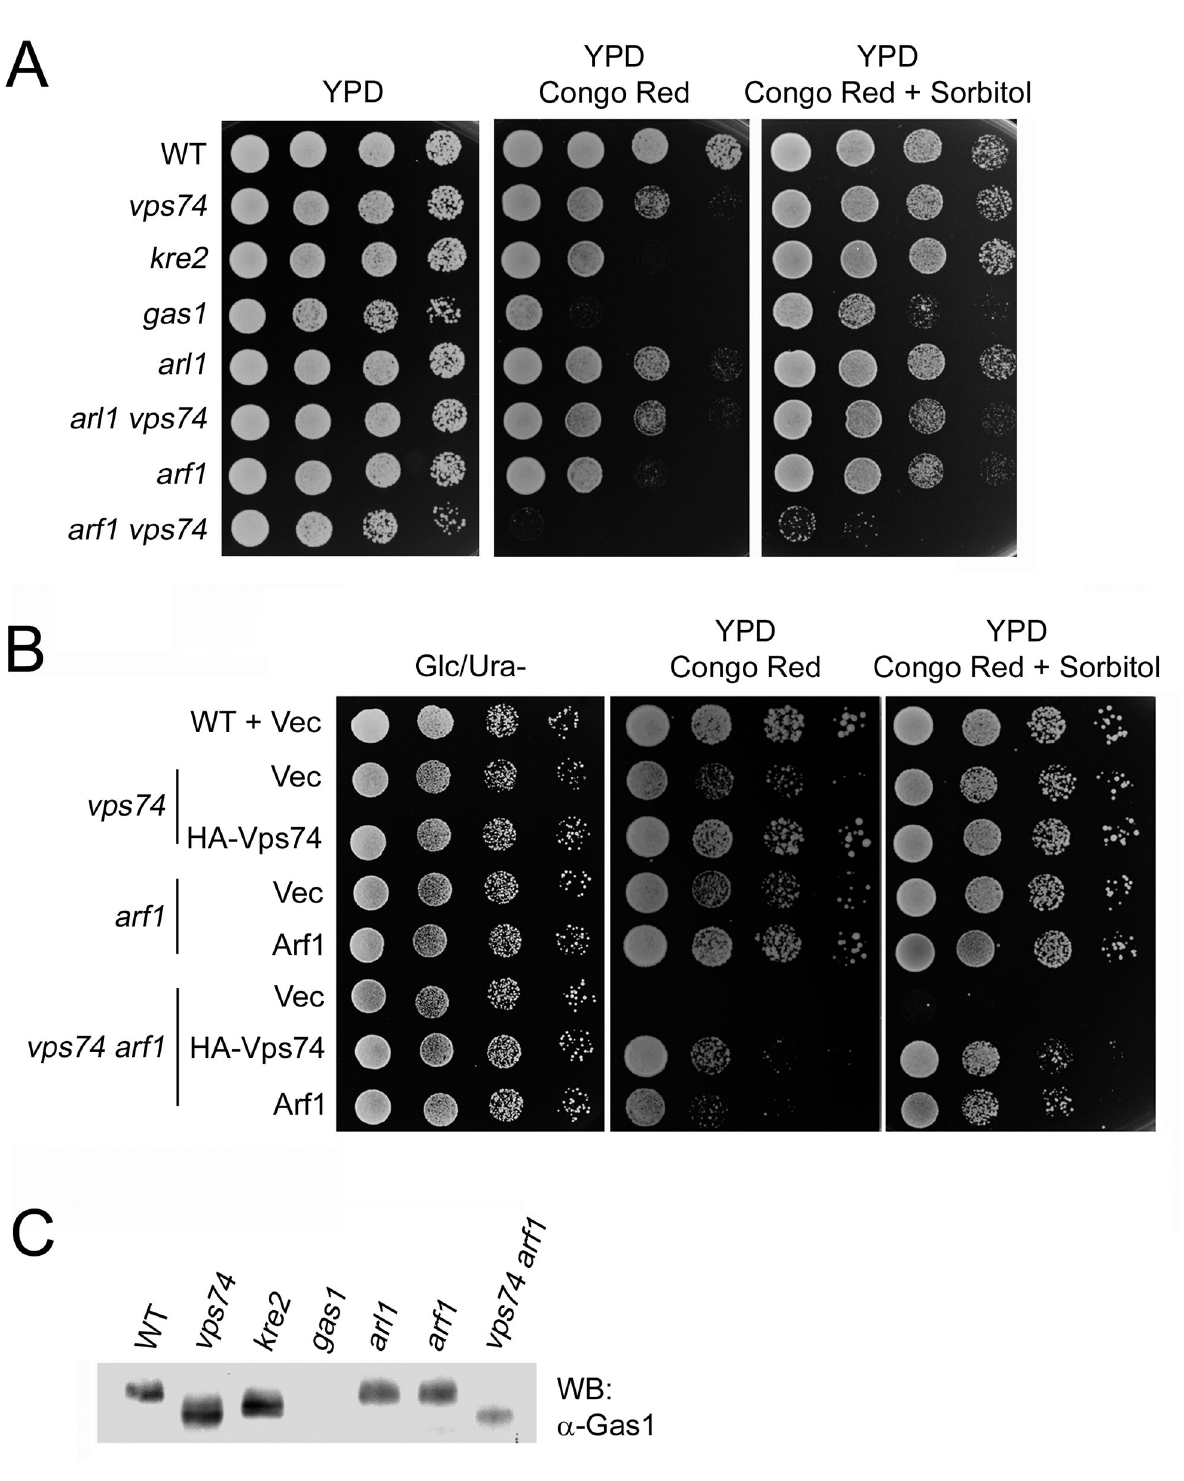
Figure 7. Deletion of VPS74 in combination with ARF1 results in a synergistic defect in cell wall integrity. (A) and (B) Indicated cells were cultured to mid-log phase, then 10-fold serial dilutions were spotted onto Ura minus plates containing 2% glucose (left panel), YPD plates containing 50 µg/ml Congo red (middle panel), or YPD plates containing 50 µg/ml Congo red and 1.2 M sorbitol (right panel). (C) Lysates were prepared from the indicated cells and proteins were precipitated with TCA to prepare an immunoblot that was probed with anti-Gas1p polyclonal antibodies. doi: 10.1371/journal.pone.0074715.g007 PLOS ONE |